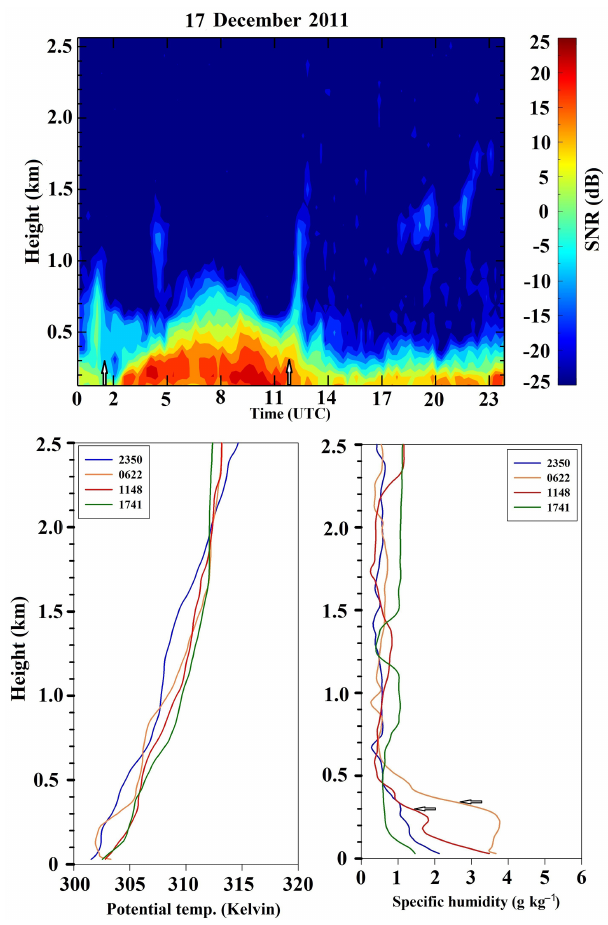
Figure 3. Mixed layer height for 17 December 2011. The upper panel shows range time intensity (RTI) plot of S/N (15 min av- eraged) measured with RWP, the vertical arrows indicate the time of sunrise and sunset. The lower panel shows the vertical profiles of potential temperature and specific humidity (horizontal arrows indicate the ML height estimated with specific humidity gradient maxima method) derived from the four radiosonde flights conducted during the day (marked with different colors).